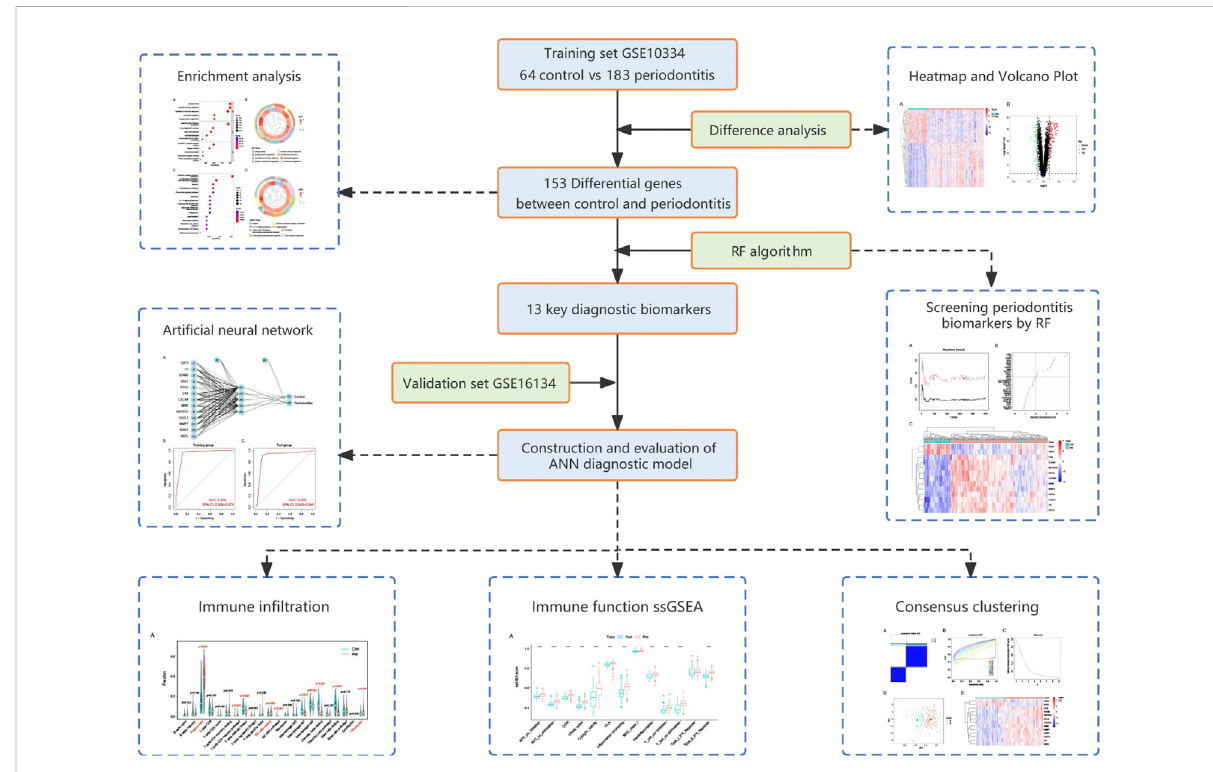
FIGURE 1 Flow chart of the present study. DEGs, differentially expressed genes; RF, random forest; ANN, arti fi cial neural